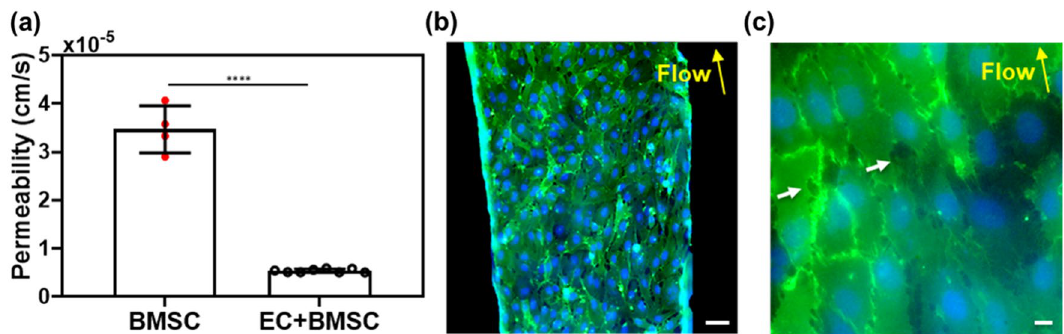
Figure 5. Permeability ( P D ) of 70 kDa FITC-dextran through the endothelium constructed between the sinusoid and stroma chambers. ECs were dynamically cultured on the membrane surface of the sinusoid chamber for 30 h. ( a ) P D measured in 6 culture samples per condition (n = 6, mean ± SD). **** P < 0.0001 determined by t-test. ( b ) and ( c ) Confocal fluorescence images of the endothelium formed after dynamic culture for 30 h. CD31 (green) and DAPI (blue). The white arrows indicate small pores located at some EC junctions. Scale bars: 100 μm in ( b ) and 10 μm in ( c ). The yellow arrows in ( b ) and ( c ) indicate the direction of flow in the sinusoid chamber.